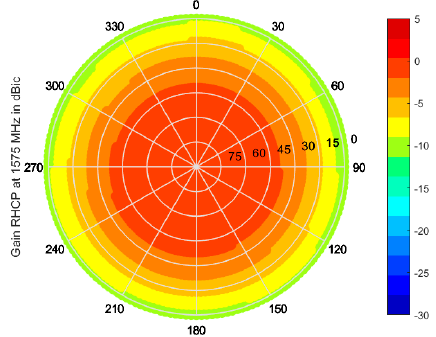
Figure 11. Sky plot of the Mode 1 RHCP gain in dBic, as measured in the anechoic chamber.